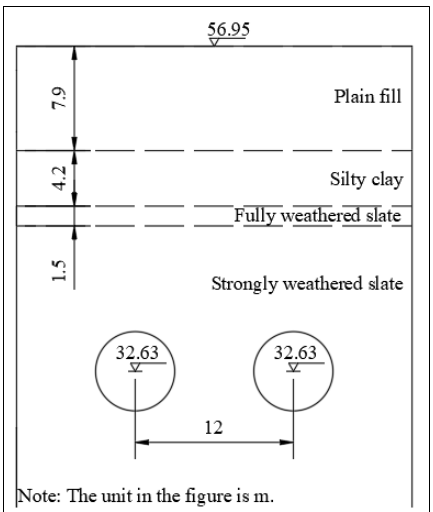
Figure 2. Schematic diagram of the cross section of the tunnel with a small radius curve.